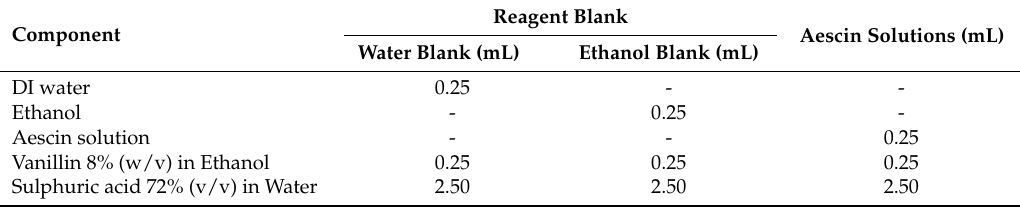
Table 3. The setup procedure for testing different solvents used to prepare saponin (aescin) solutions.